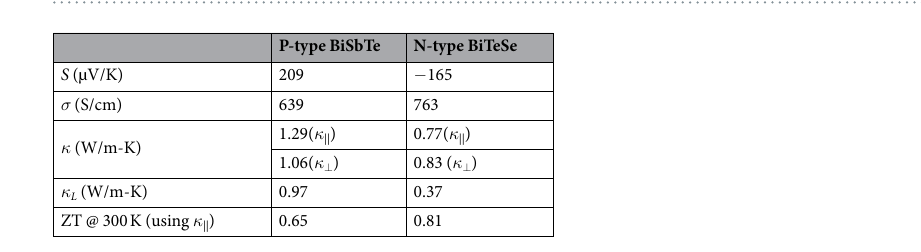
Table 1. Summary of thermoelectric properties of printed p-type BST and n-type